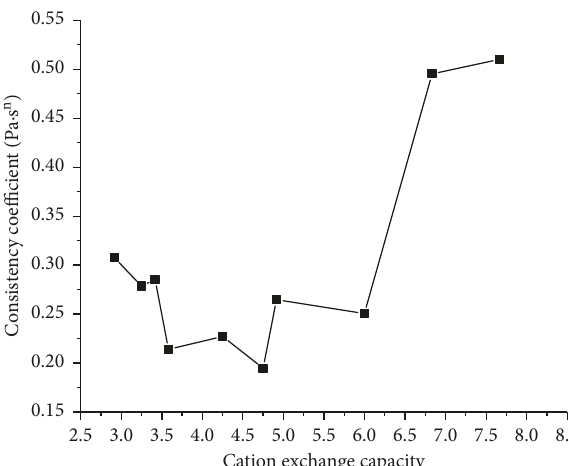
Figure 7: Curve of consistency coefficient of slurry fluid.